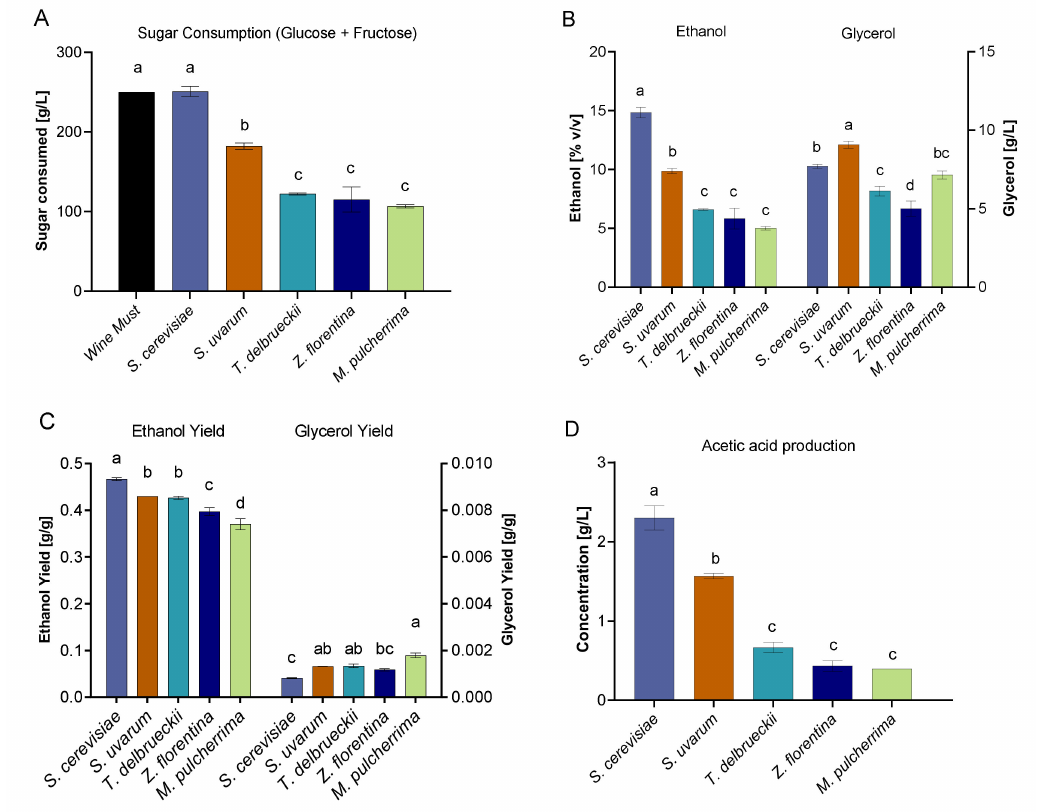
Figure 5. HPLC results from fermentation with Saccharomyces and non- Saccharomyce s strains. ( A ). Sugar consumption, ( B ) Ethanol and Glycerol production, ( C ) Ethanol and Glycerol yields, and ( D ) Acetic acid